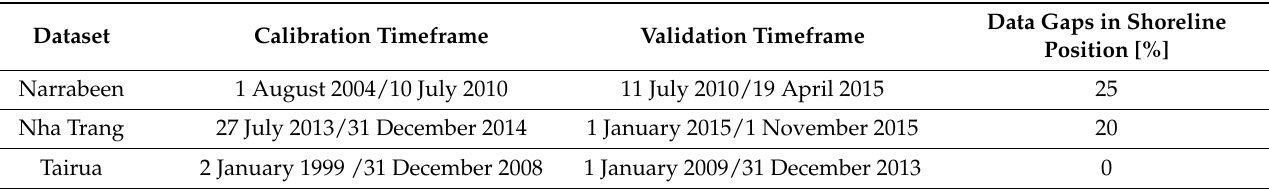
Table 1. Calibration and validation timeframes of the Narrabeen, Nha Trang and Tairua dataset, as well as the percentages of data gaps in the shoreline position data (based on daily